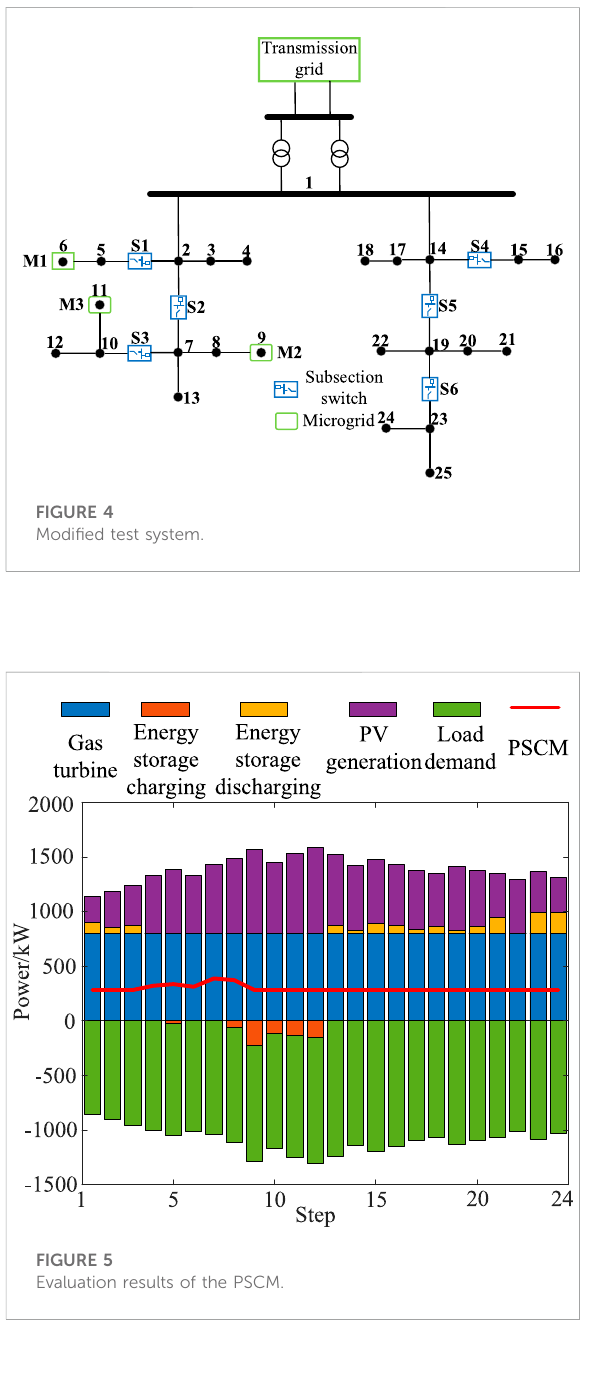
TABLE 2 Computation performance of different